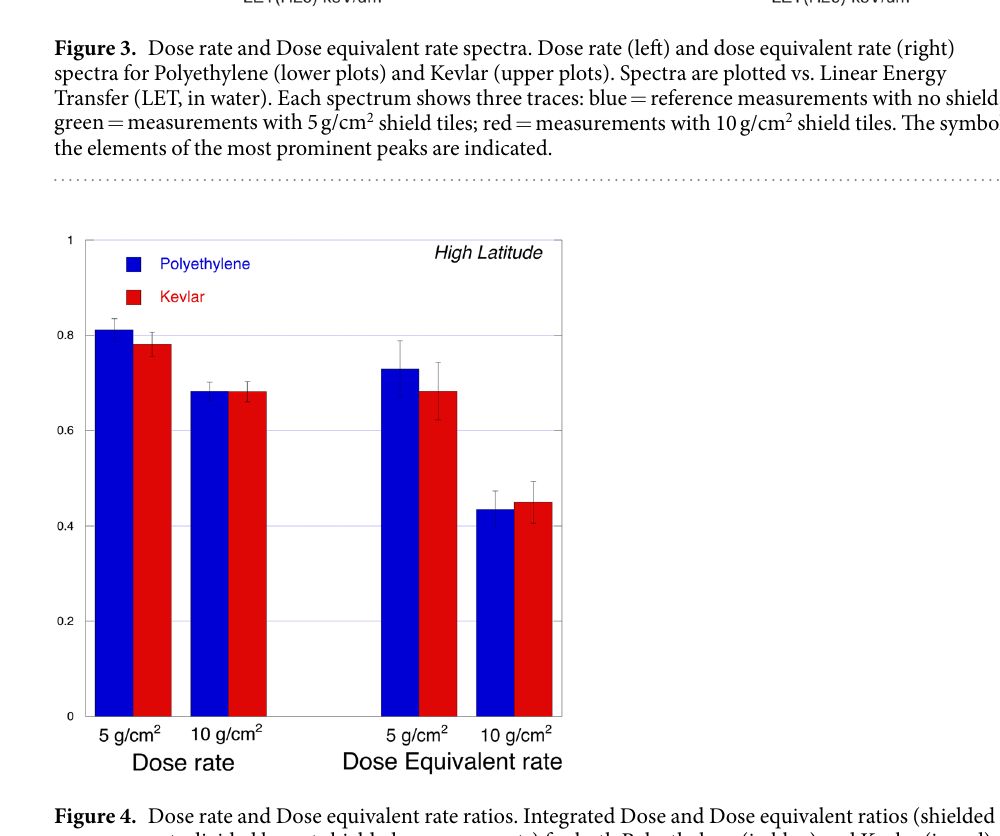
Figure 5 shows the evolution of the shielding effectiveness across LETs. In the top part, the ratio between the shielded (5 and 10 g/cm 2 ) to unshielded dose rate measurements is presented. The population of LET bins is fast decreasing with LET (see Fig. 3), so the ratio of dose rate (shielded to unshielded) in this figure is integrated in